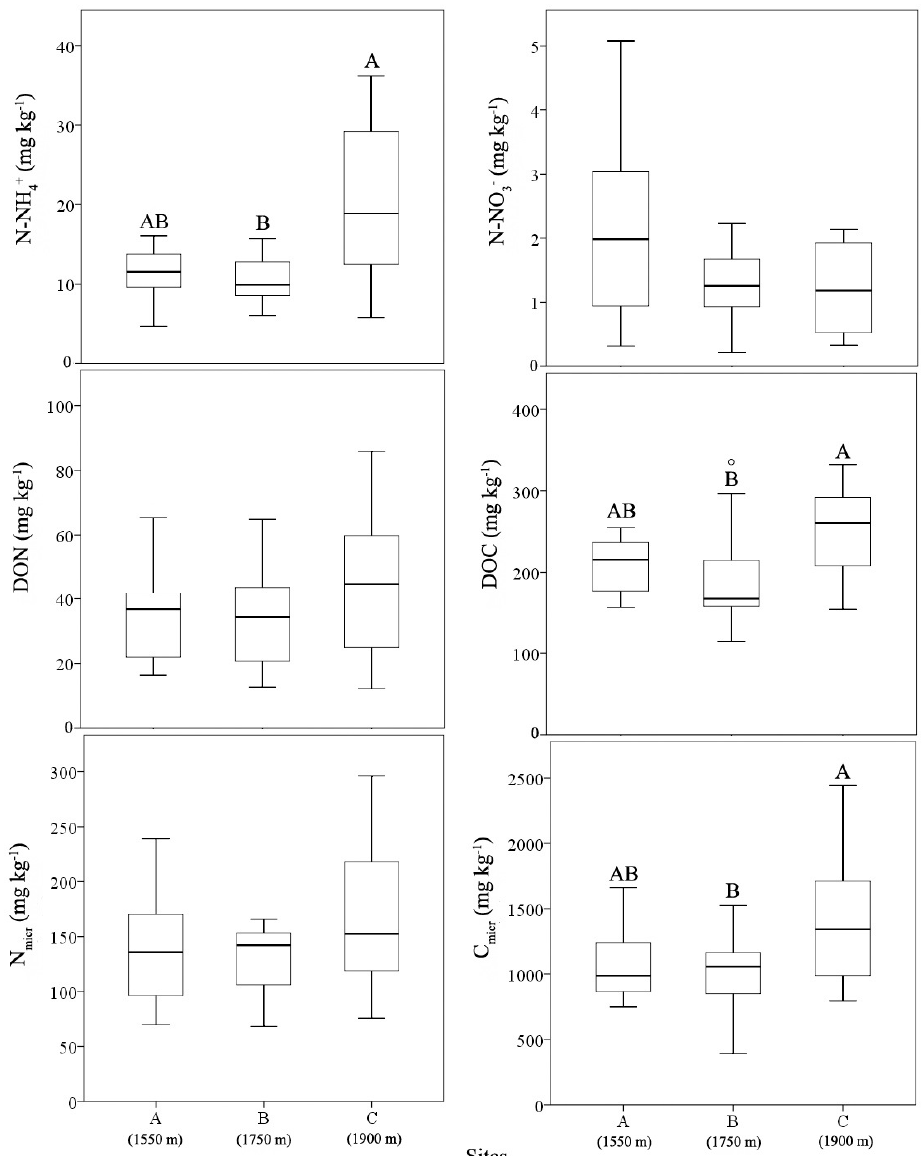
Figure 5. Extractable N-NH 4 + , N-NO 3 − , DON, DOC, N micr , and C micr (mg kg − 1 ) in the 3 study sites (mean values measured during the 2015 and 2016 snow-free seasons), n = 81. Letters, where included, indicate significant differences ( p < 0.05) between sites.